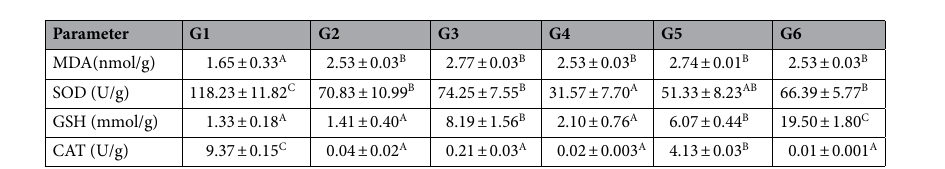
Figure 12. Immuno-histochemical localization of Caspase protein (red arrow) in the tumor and muscle tissues of the negative control (G1), tumor control (G2), Doxorubicin treated (G3) and PSO treated (G4–G6) groups (Caspase immunostain × 200).